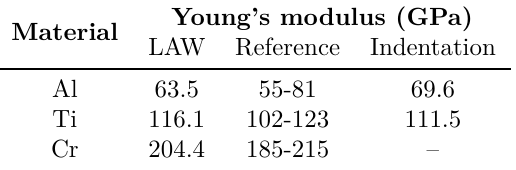
Table 1. Comparison of Young’s modulus values of Al, Ti, Cr thin film measured by LAW, nanoindentation and literature